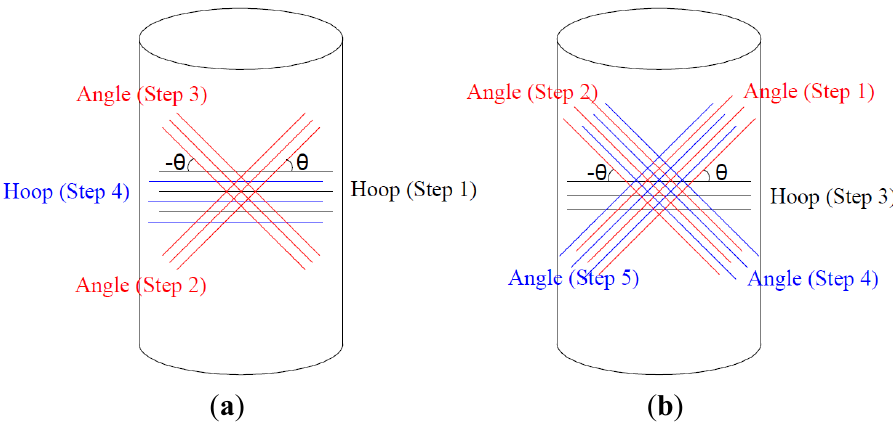
Figure 2. Ply configurations in fiber reinforced polymers (FRP)-wrapped